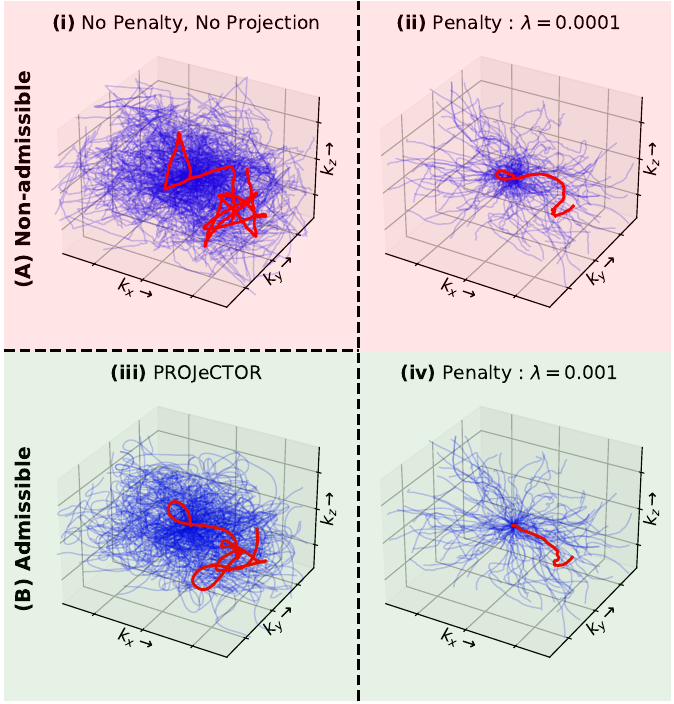
Figure 5. Comparison of ( iii ) PROJeCTOR trajectories with respect to penalty-based versions ( ii , iv ). The ( A ) non-admissible trajectories are shaded in red, while ( B ) admissible trajectories are shaded in green. Additionally, unconstrained (no penalty and no projection) trajectories are also presented in ( i ).